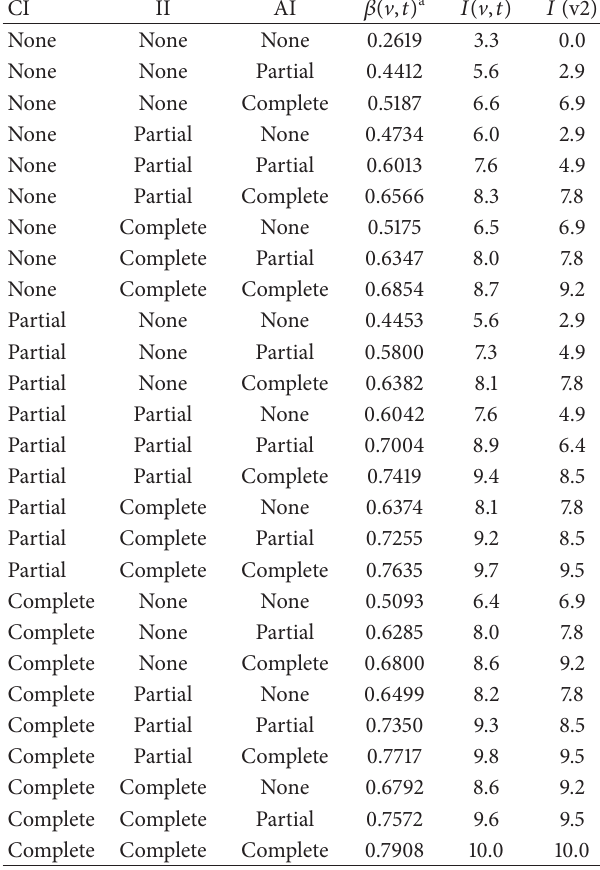
Table 6: Theoretical impact score comparison where 𝑡 = 2012